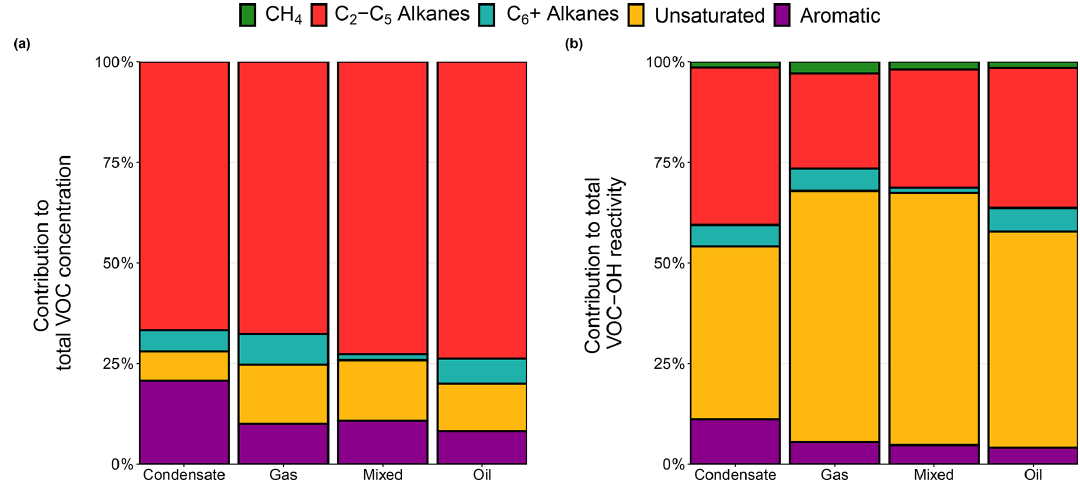
Figure 6. Percentage contribution of different VOC categories to (a) total VOC concentrations by mass and (b) total VOC–OH reactivity measured for each field type. The contribution of CH 4 is shown only for OH reactivity to demonstrate the relative importance of the other VOCs in terms of O 3